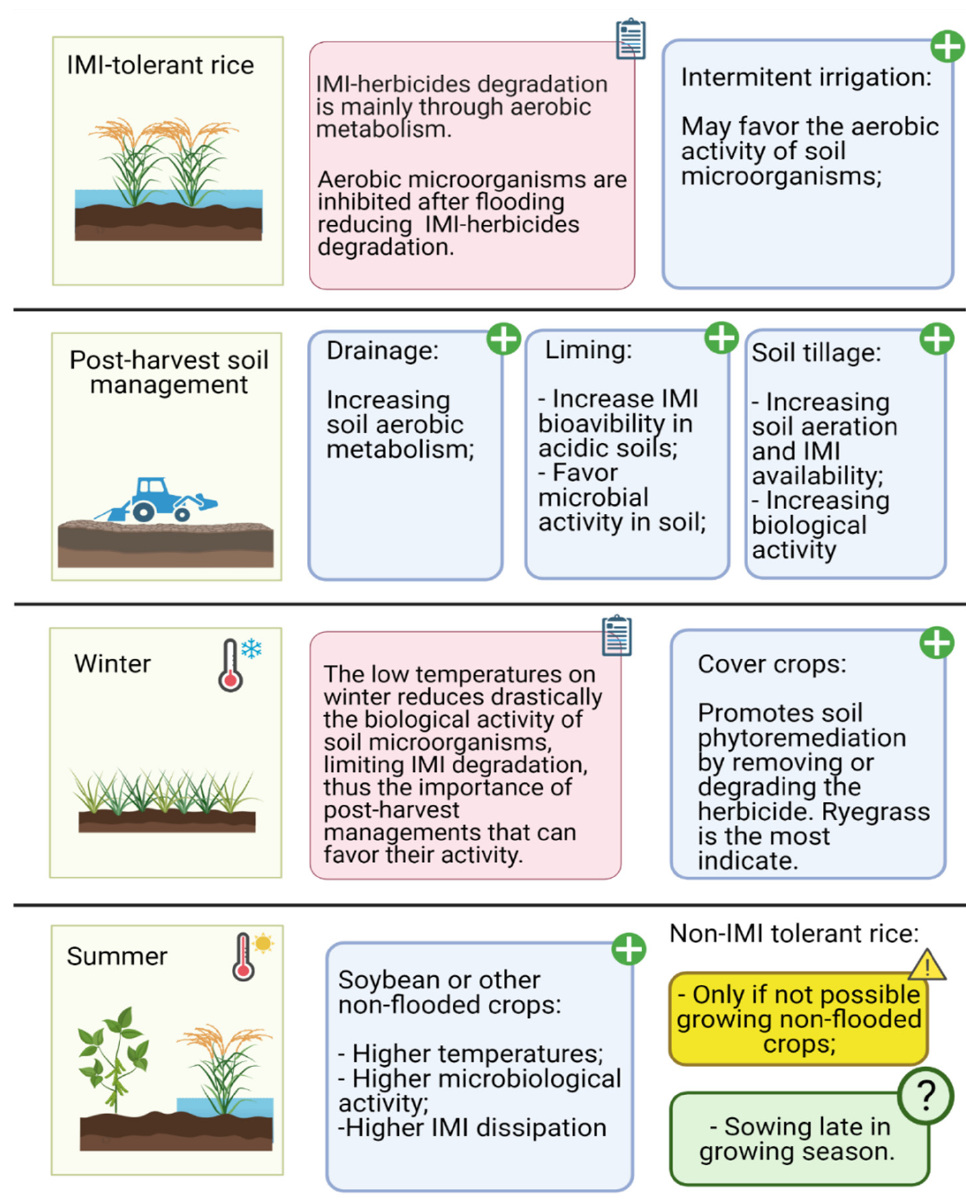
Figure 12. Summary of the recommendations to mitigate imidazolinone persistence in rice soils. From top to bottom is the timeline starting with the rice season using imidazolinone-resistant genotypes. The blue boxes indicate factors that favor the mitigation of the carryover effect; the red box indicates situations that limit the degradation of imidazolinones; the yellow box indicates alerting situations in which there may be an effect of carryover on subsequent crops; and the green box indicates a suggestion for which there may be reduction of the carryover effects in non-tolerant rice.